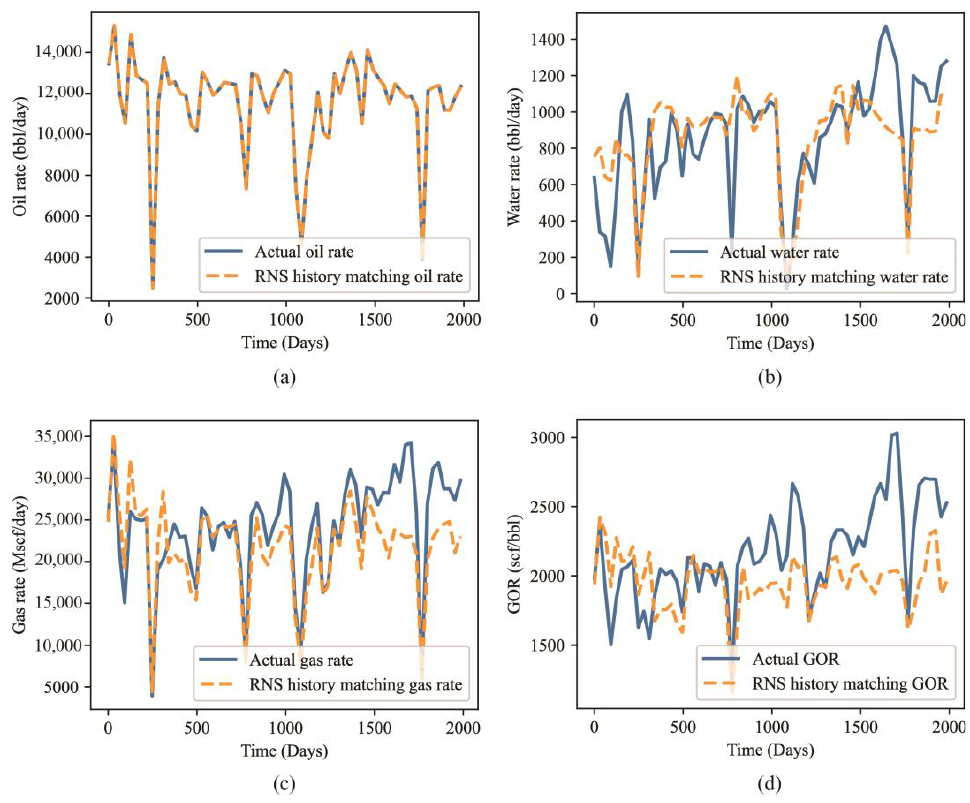
Figure 9. RNS history matching performance of target area: ( a ) Oil rate; ( b ) Water rate; ( c ) Gas rate; ( d ) GOR rate.